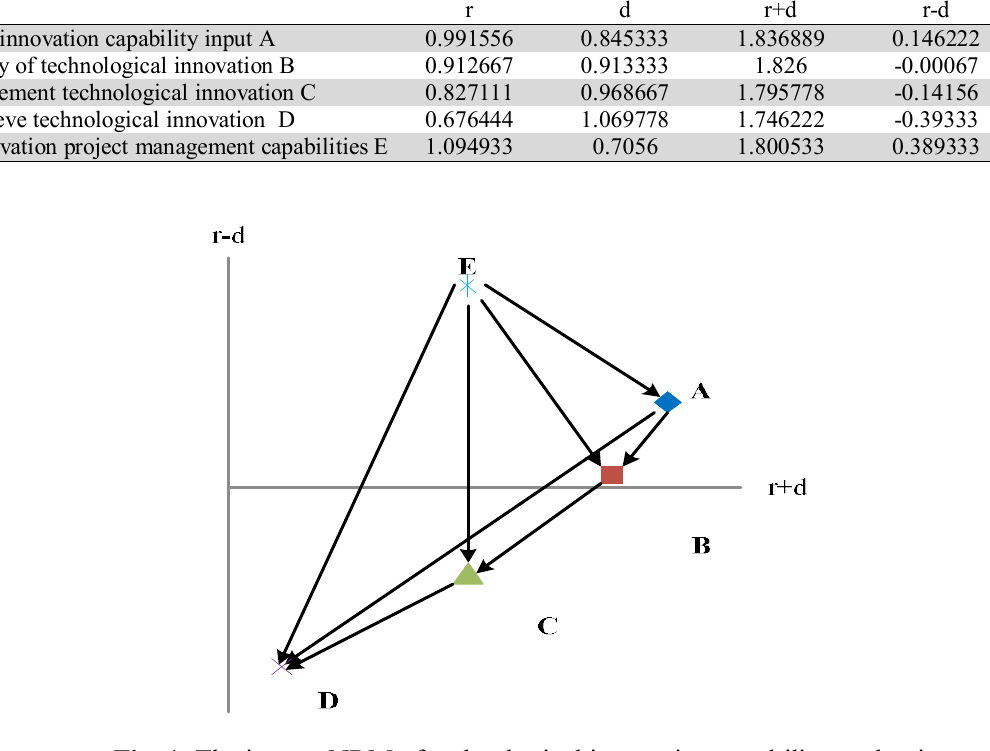
Fig. 1. The impact NRM of technological innovation capability evaluation